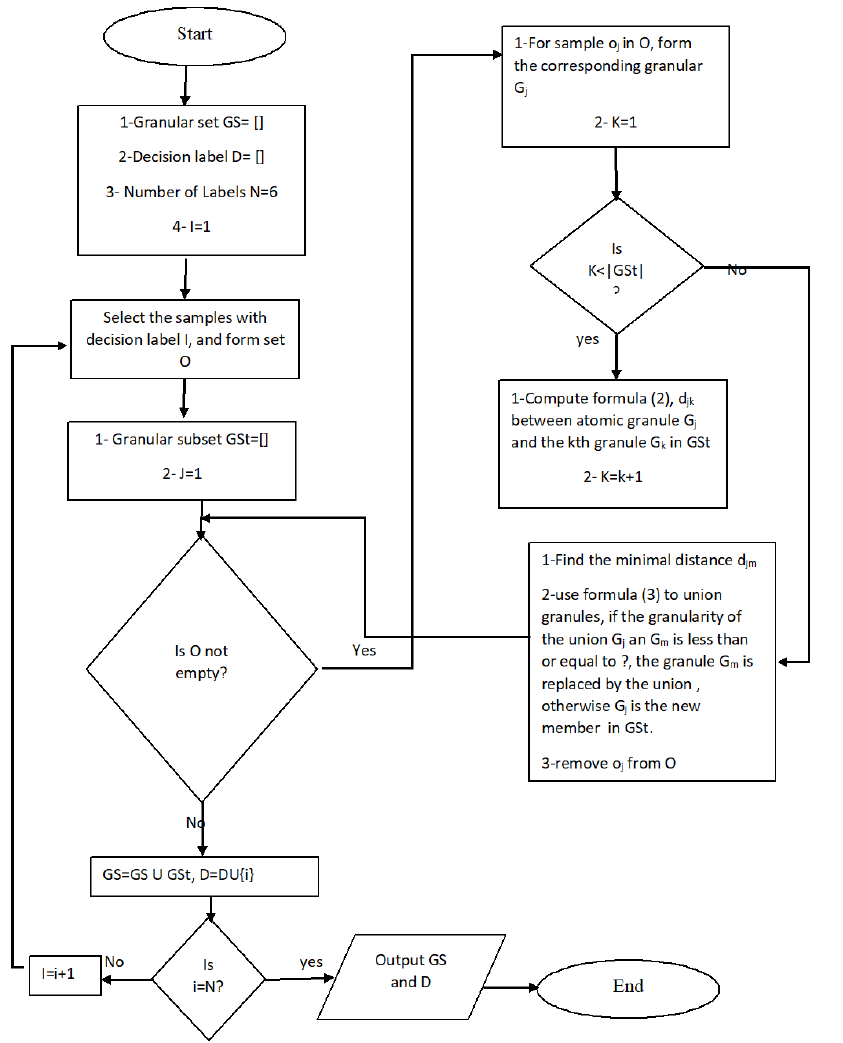
Figure 5. The Granular Computing Network